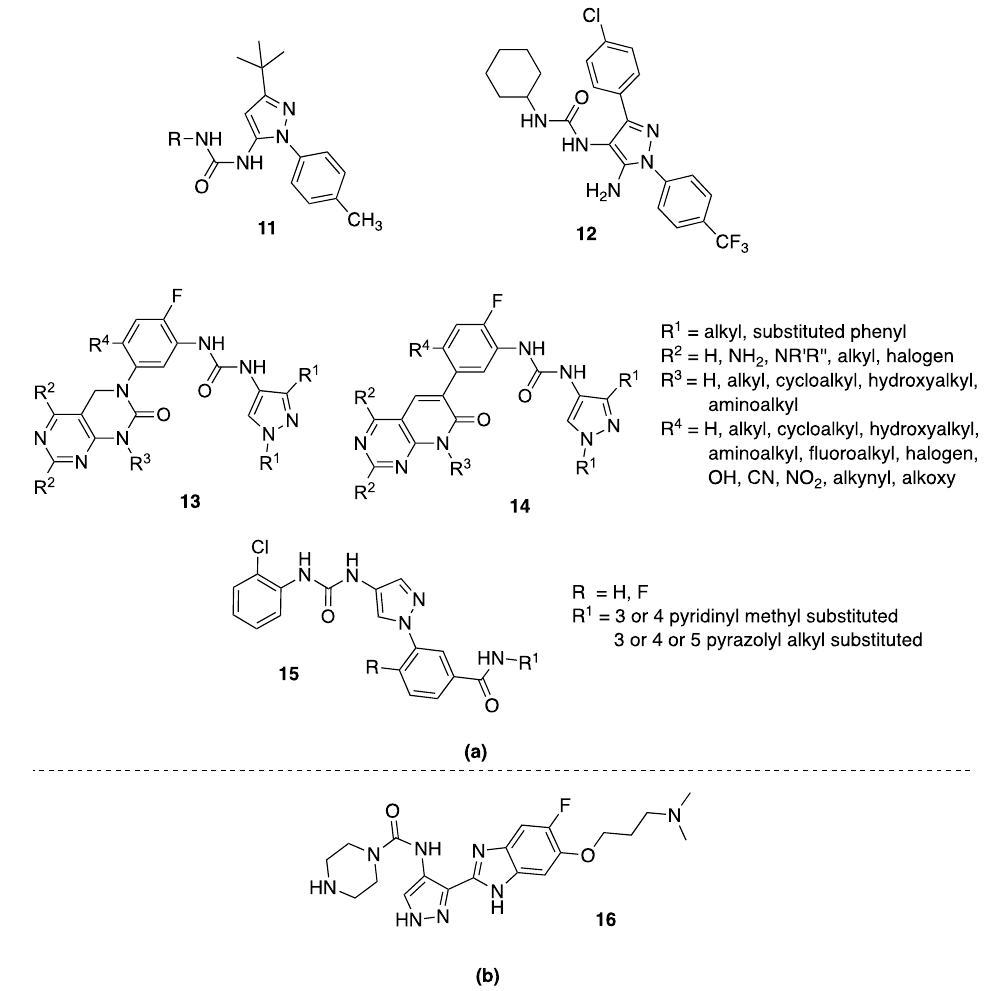
Figure 3. 4-Pyrazolyl-ureas reported as: ( a ) protein kinases inhibitors; ( b ) anticancer agents.